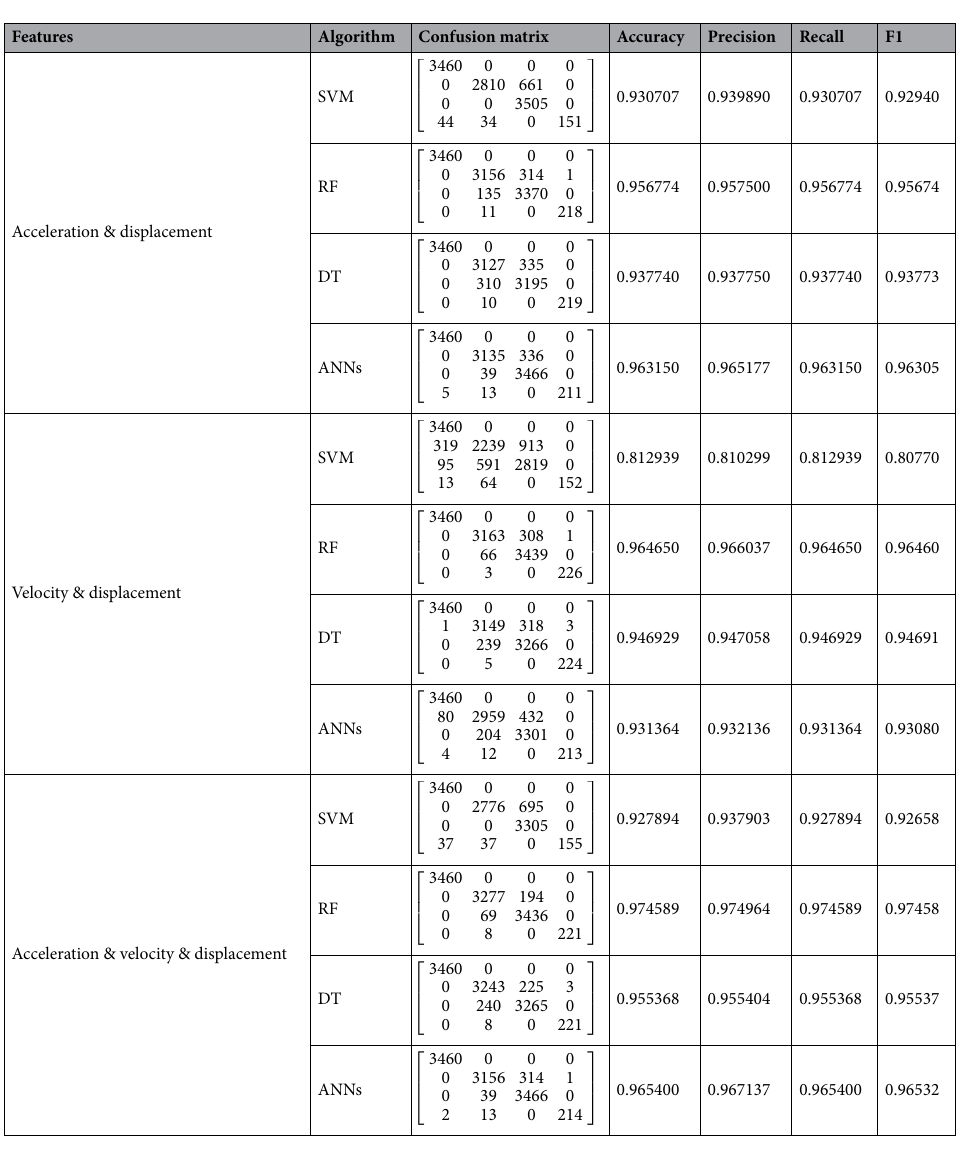
Table 3. Machine learning